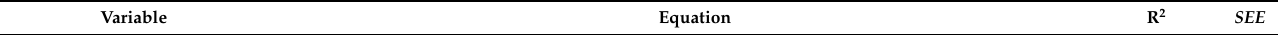
Table 3. Regression equations to predict ADRV-as based on socioeconomic parameters. Variable Equation R 2 SEE